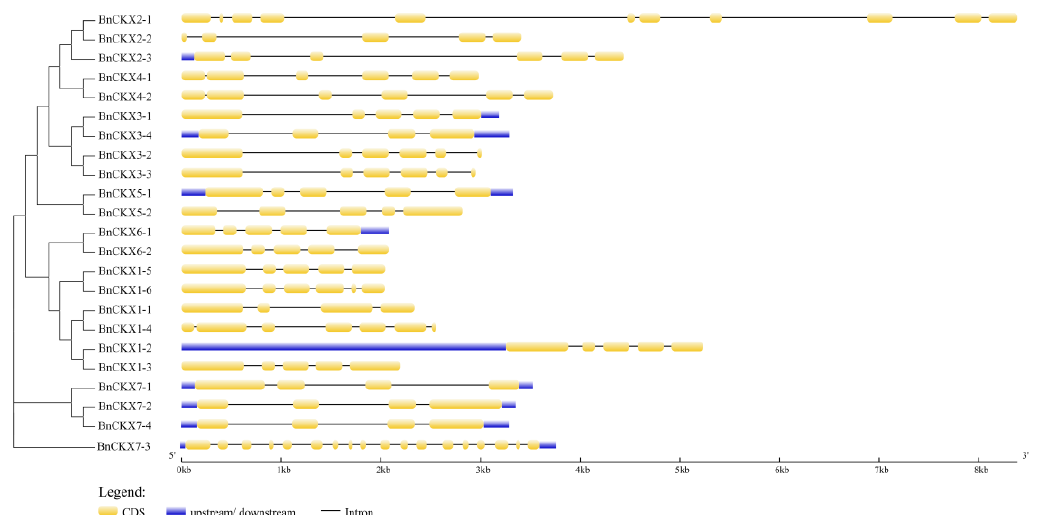
Figure 3. Exon – intron structures of the BnCKX genes according to their phylogenetic relationships. An unrooted phylogenetic tree was constructed with 1000 bootstrap replicates based on the full-length sequences of BnCKX proteins. Exon – intron structure analysis of the BnCKX genes was performed using the online tool Gene Structure Display Server (GSDS). The lengths of the exons and introns of each BnCKX gene are drawn to scale.